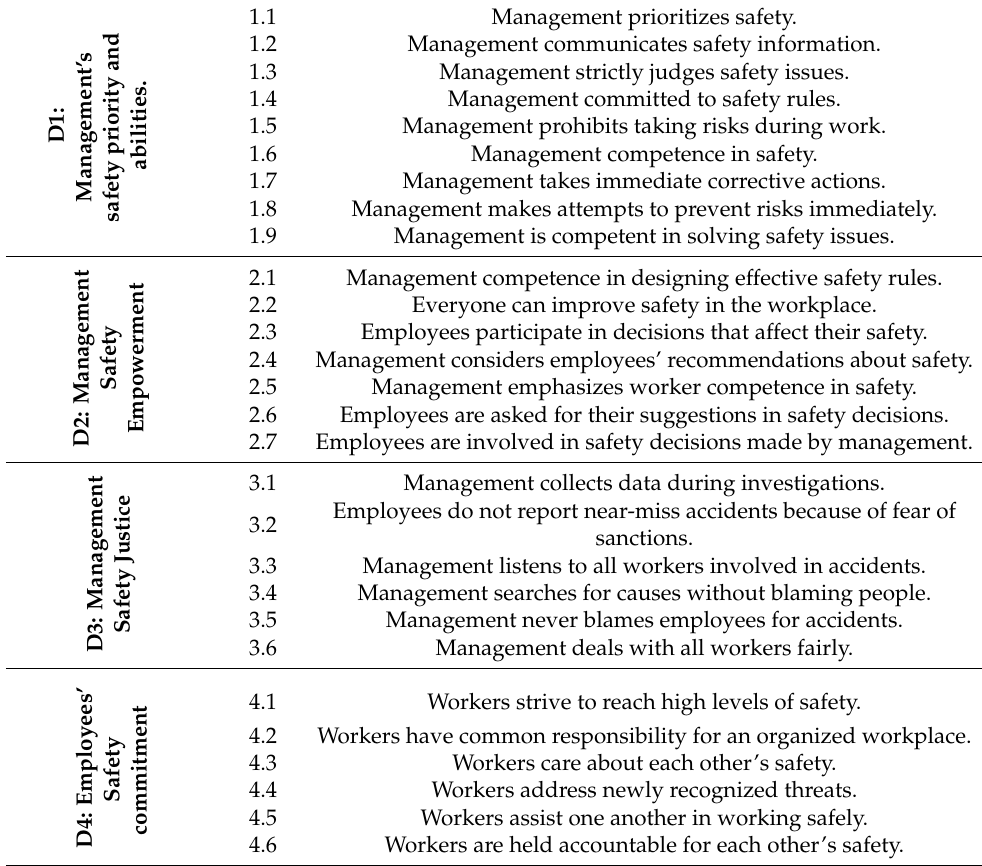
Table 2. NOSACQ-50 safety dimensions, with their